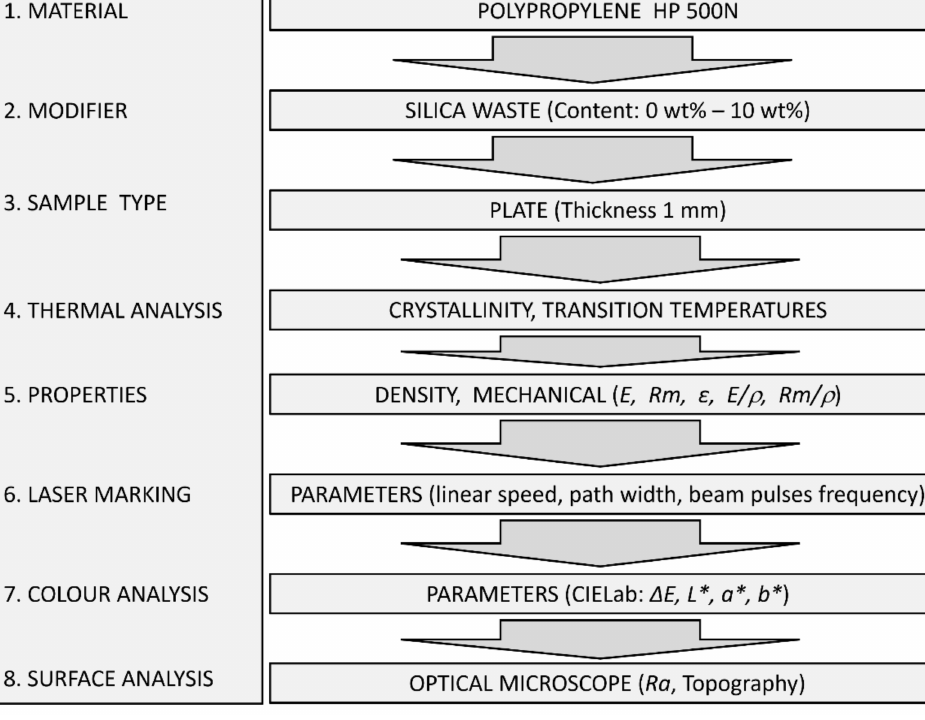
Figure 4. Experiment flow diagram with input and output